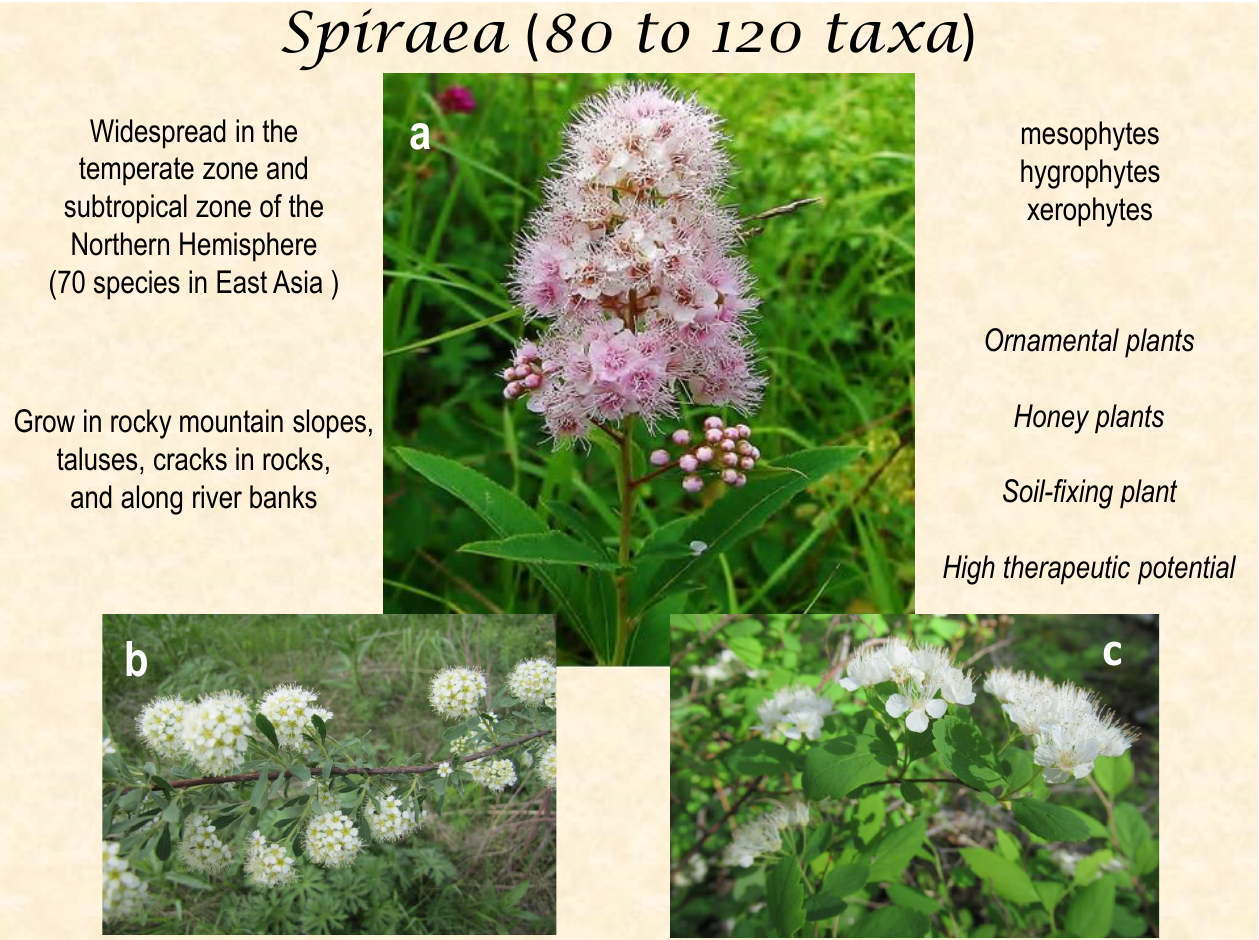
Figure 1. Plants of the genus Spiraea (some representatives: ( a ) S. salicifolia ; ( b ) S. crenata ; and ( c ) S. ussuriensis ). The ethnomedicinal uses of spireas have been documented in North America, Russia, and Asia. Spireas are employed as effective therapeutics for inflammation and malaria